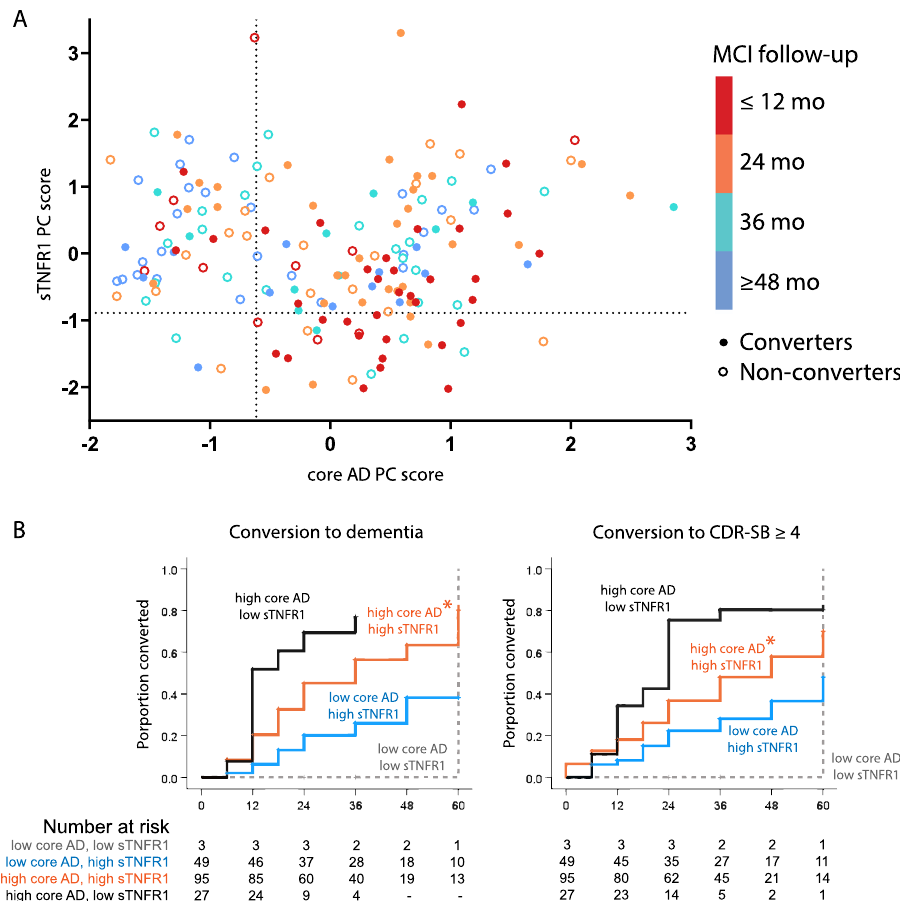
Fig. 1 Relationship between two protein family scores (core AD and sTNFR1-related) and conversion from MCI to dementia. Following principal component analysis, core AD principal component (PC) score corresponding to t-Tau/A β 42 of 0.39 (predicted ADNC threshold) and sTNFR1 PC score corresponding to no net decline at this core AD score were used to stratify ADNI mild cognitive impairment (MCI) participants ( A ). Circle colors represent follow-up time, with converters shown as fi lled circles and non-converters shown as open circles. Participants with high core AD and low sTNFR1 scores had the shortest median time to conversion, followed by those with high scores in both and those with low core AD score ( B * p = 0.014 with dementia diagnosis as outcome; † p = 0.007 with clinical dementia rating-sum of boxes score [CDR-SB] ≥ 4 as outcome). Source data are provided as a Source Data fi